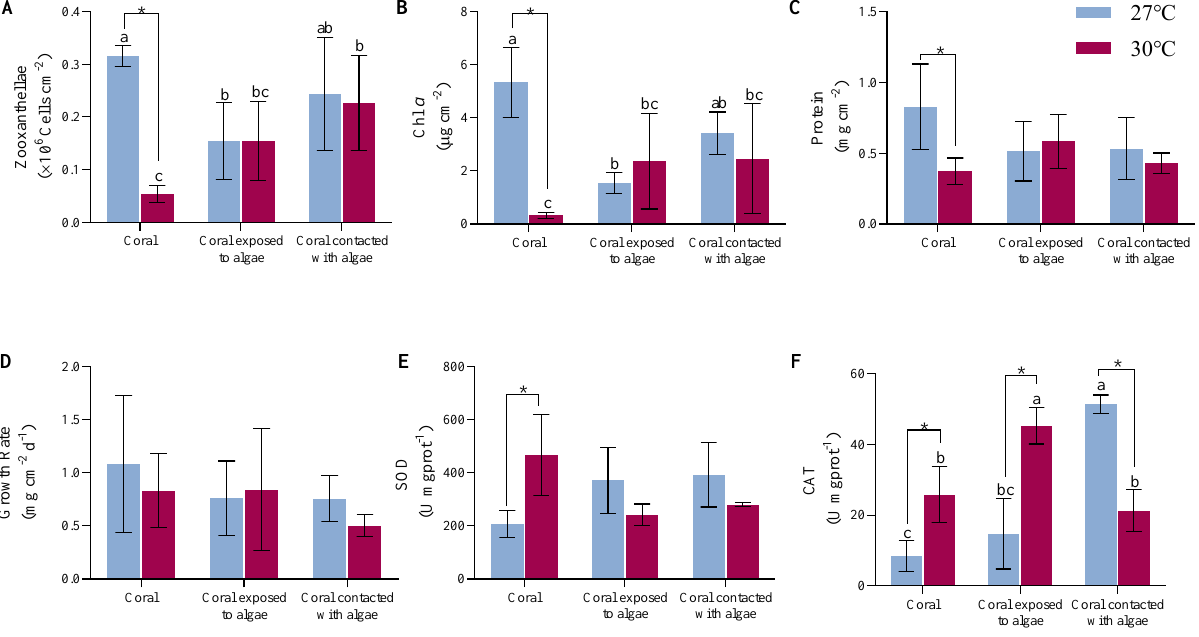
Figure 2. Summary of physiological indicators. The effect of different temperatures of 27 °C (blue) and 30 °C (red) on the ( A ) zooxanthellae, ( B ) Chl a , ( C ) protein content, ( D ) growth rate, ( E ) SOD, and ( F ) CAT of macroalgae-treated corals after 4 weeks of the experiment. Different letters indicate that there are significant differences between the macroalgae treatments at the same temperature ( p < 0.05), * indicates that there are significant differences between the different temperatures ( p < 0.05). Data are expressed in terms of the mean ± standard deviation, n = 3. The source data and two-factor analysis of variance (ANOVA) data are provided as a source data file in Tables S3 and S4.